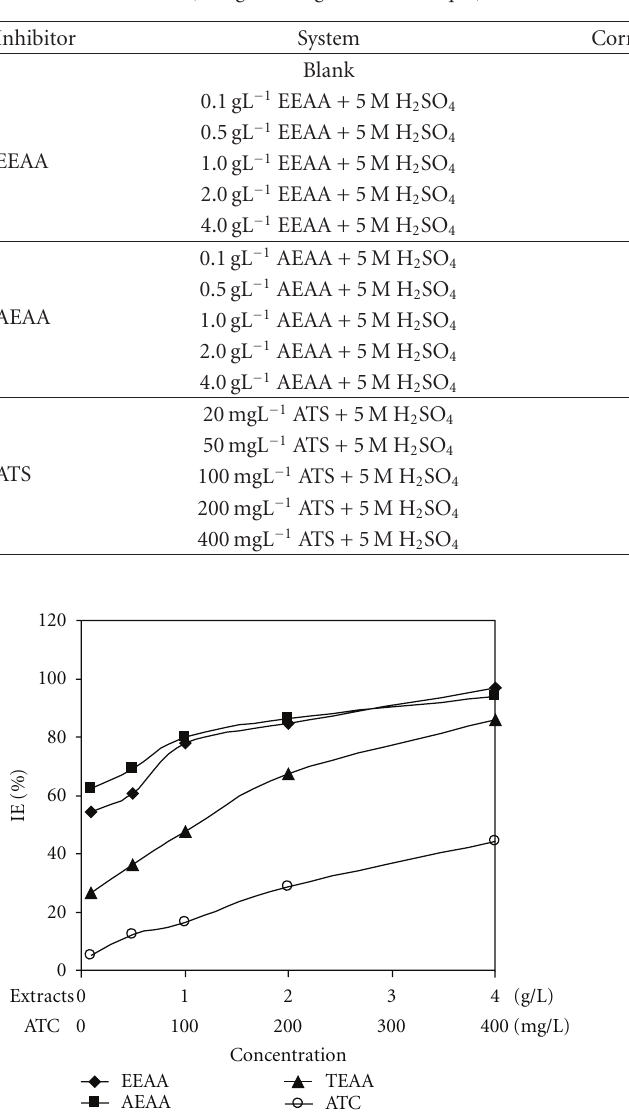
Table 2: Calculated values of the corrosion rate and inhibition e ffi ciency for mild steel coupons in 1.0 M H 2 SO 4 solutions in the absence and presence of inhibitors (using the weight loss technique).